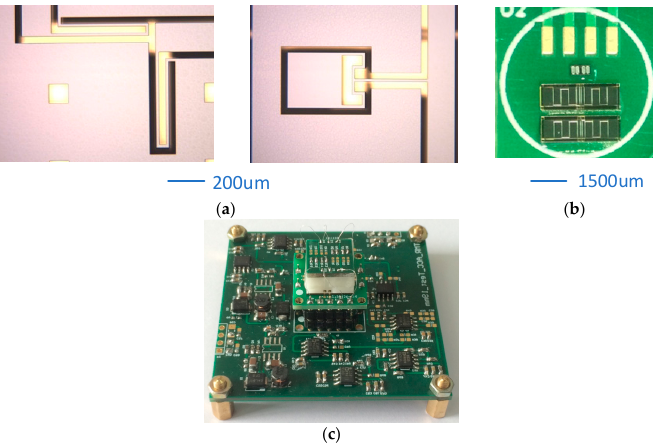
Figure 9. The optical micrograph of micromachined z-axis tunnel magnetoresistive accelerometer. ( a ) The plane main structure of tunnel magnetoresistive accelerometer; ( b ) Commercial tunnel magnetoresistive sensor; ( c ) Micro-assembled overall structure.